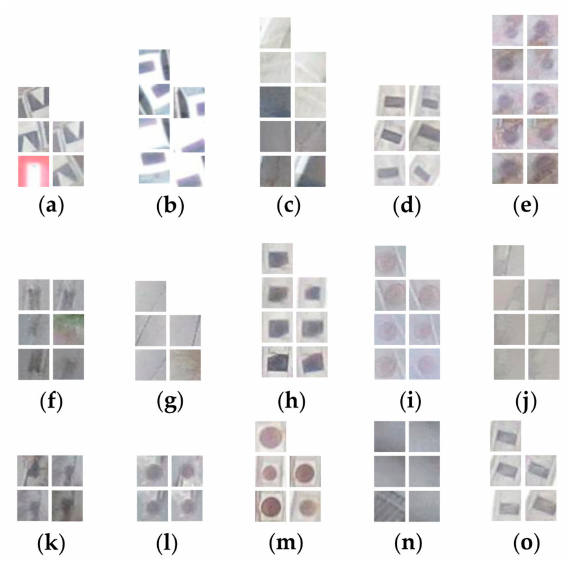
Figure 9. Examples of locations falsely classified as sewer inlets. Each subplot shows all views available for a given location. The apparent main causes for false classification are: ( a , b , d , f , h , k , o ) patterns on ground with high contrast and/or strong geometric patterns; ( e , i , l , m ) manholes or possibly round sewer inlets. ( c , g , j , n ) were falsely classified as sewer inlets for unknown reasons. In Figure 10, the 15 sewer inlets with the lowest detection scores are shown. The following reasons may have caused them to not detected: (i) insufficient image quality or obstruction (6 cases); (ii) too few images in which the sewer inlet is visible (5 cases); (iii) they are visually different from typical inlets used for training (5 cases); (iv) the object surroundings are complex or unusual (2 cases); or (v) the image pose or DSM is imprecise (1 case).